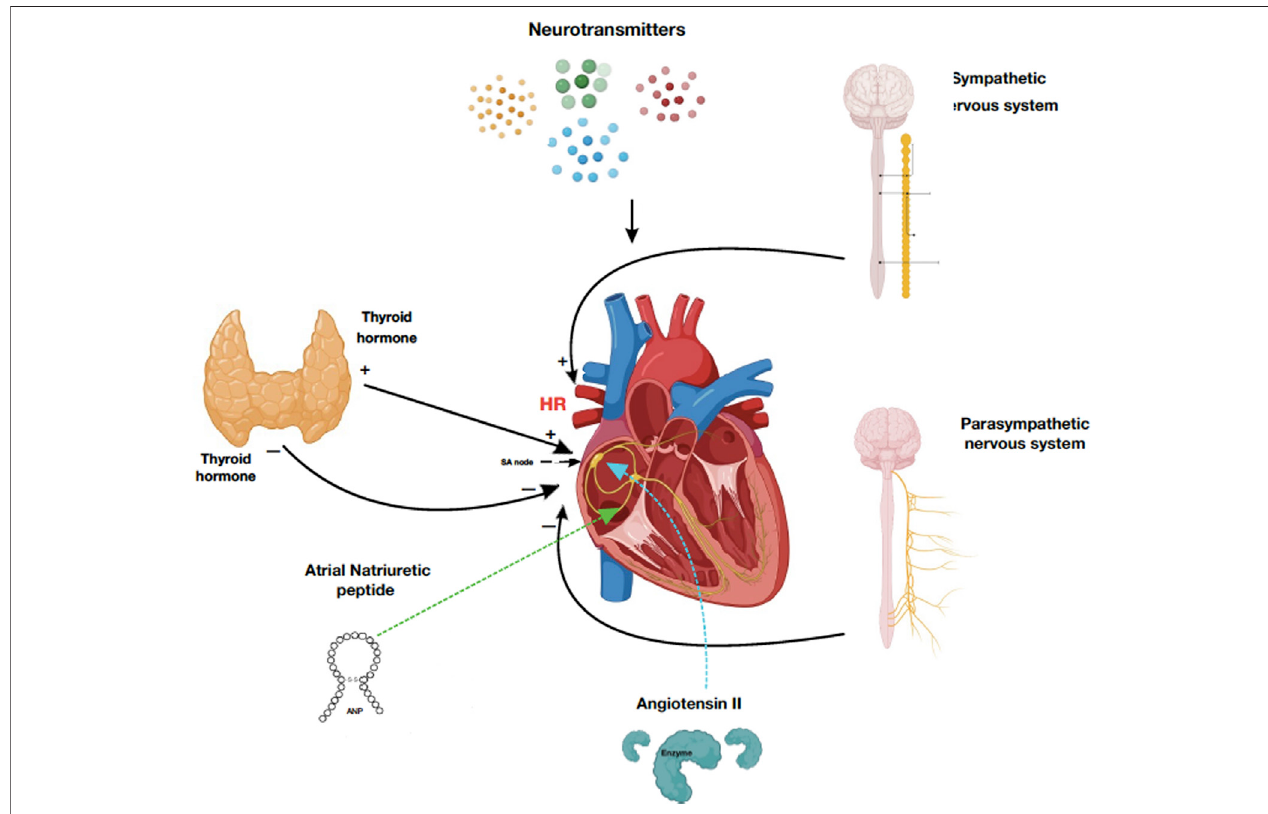
FIGURE1| SchematicdiagramsofTENGsoperationmodes. (A) :verticalcontactseparationmode, (B) :freestandingtriboelectriclayermode, (C) :singleelectrode mode (D) : lateral sliding mode.